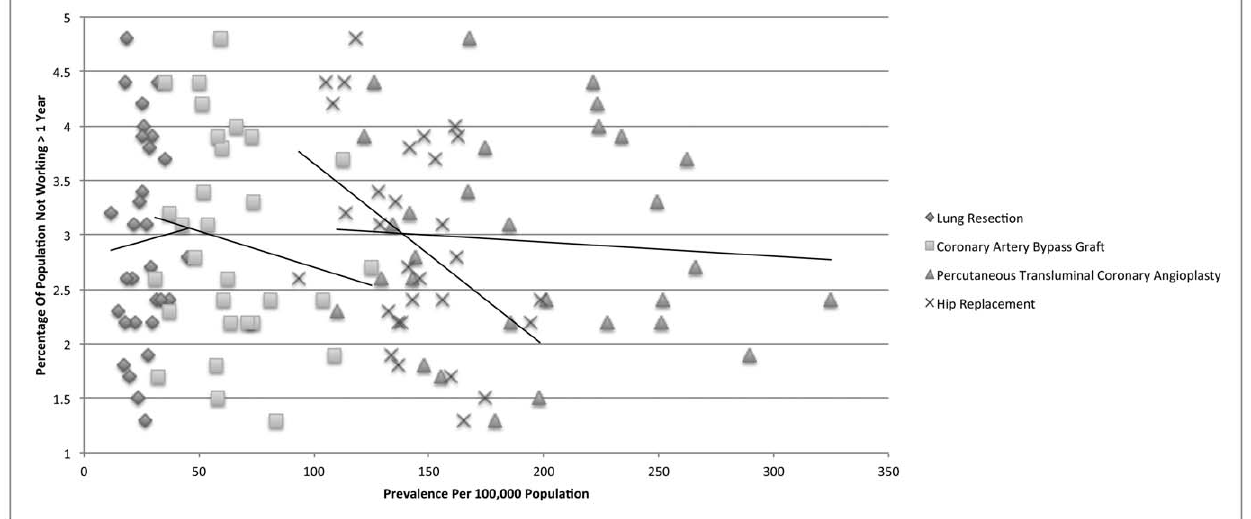
Figure 2. Unemployment for greater than one year is not associated with advanced coronary artery disease.